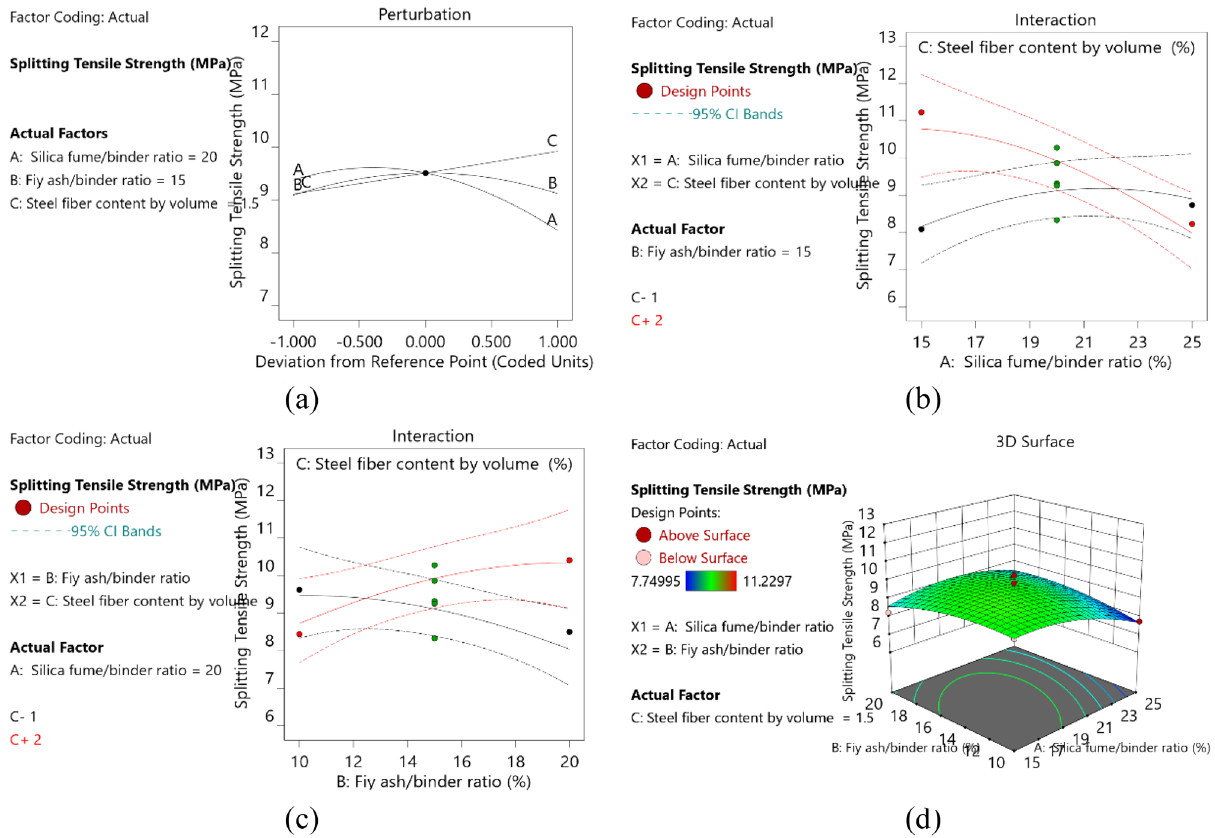
Figure 5. ( a ) Perturbation plot for split tensile strength ( b ) AC interaction, B = 15 ( c ) BC interaction, A = 20 ( d ) 3D response diagram of split tensile